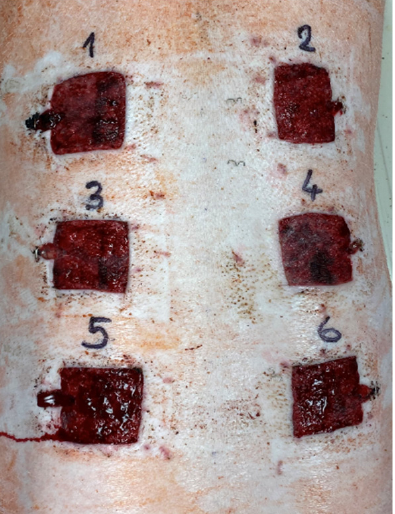
Figure 7. Position of the wounds on pig’s dorsum (state 7 days